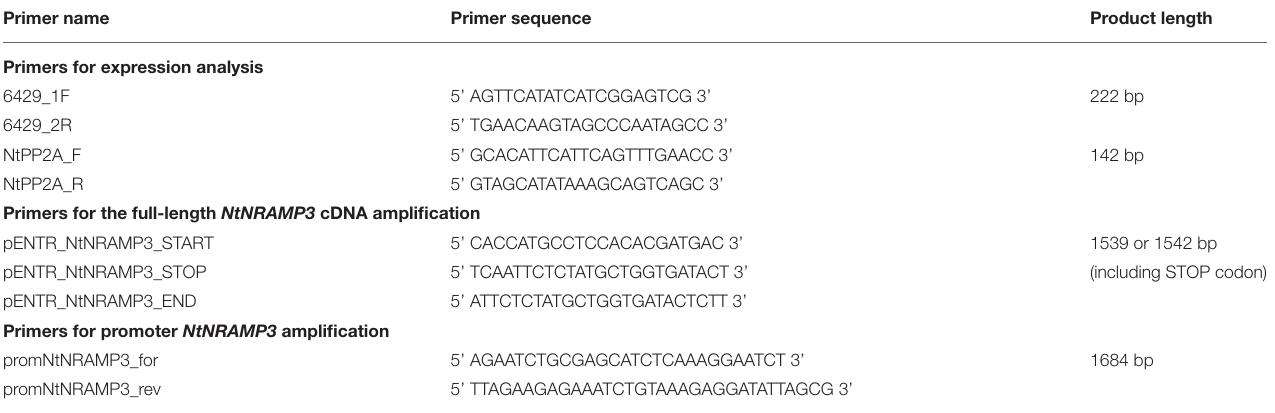
TABLE 1 | Sequences of primers used in the